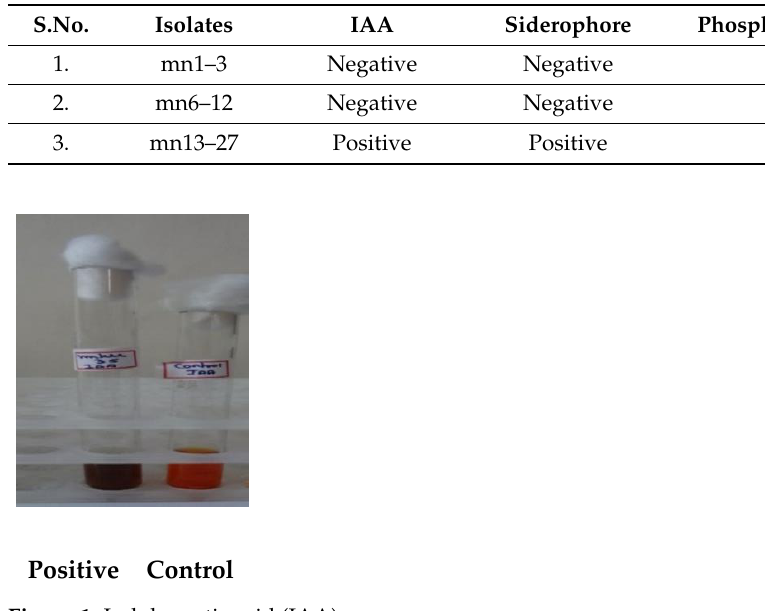
Figure 1. Indole acetic acid (IAA).